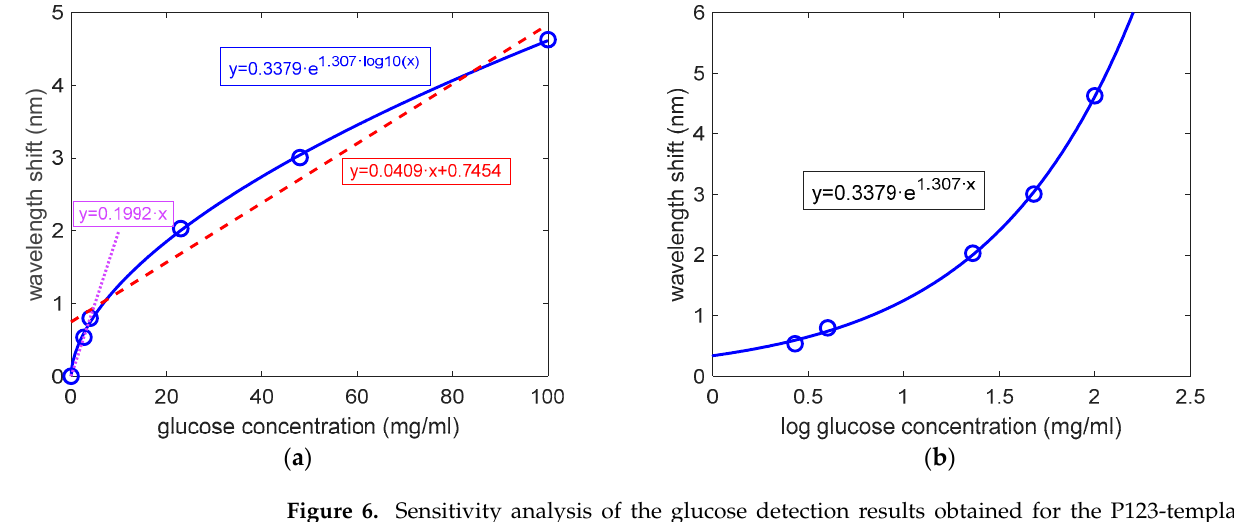
Figure 6. Sensitivity analysis of the glucose detection results obtained for the P123-templated mesoporous TiO 2 tri-layer, where a time of 5 min has been considered for the stabilization of the sensing signal after the injection of each glucose cycle (experimental sensing results depicted with blue circles). ( a ) The red dashed line and the blue solid lines correspond to the fitting of the experimental sensing results to a linear function and to an exponential function, respectively. The purple dotted line corresponds to the linear fitting of the experimental sensing results for glucose concentrations below 5 mg/mL. ( b ) Sensitivity curve corresponding to the fitting of the experimental results to an exponential curve when the logarithm of the glucose concentration is considered on the x